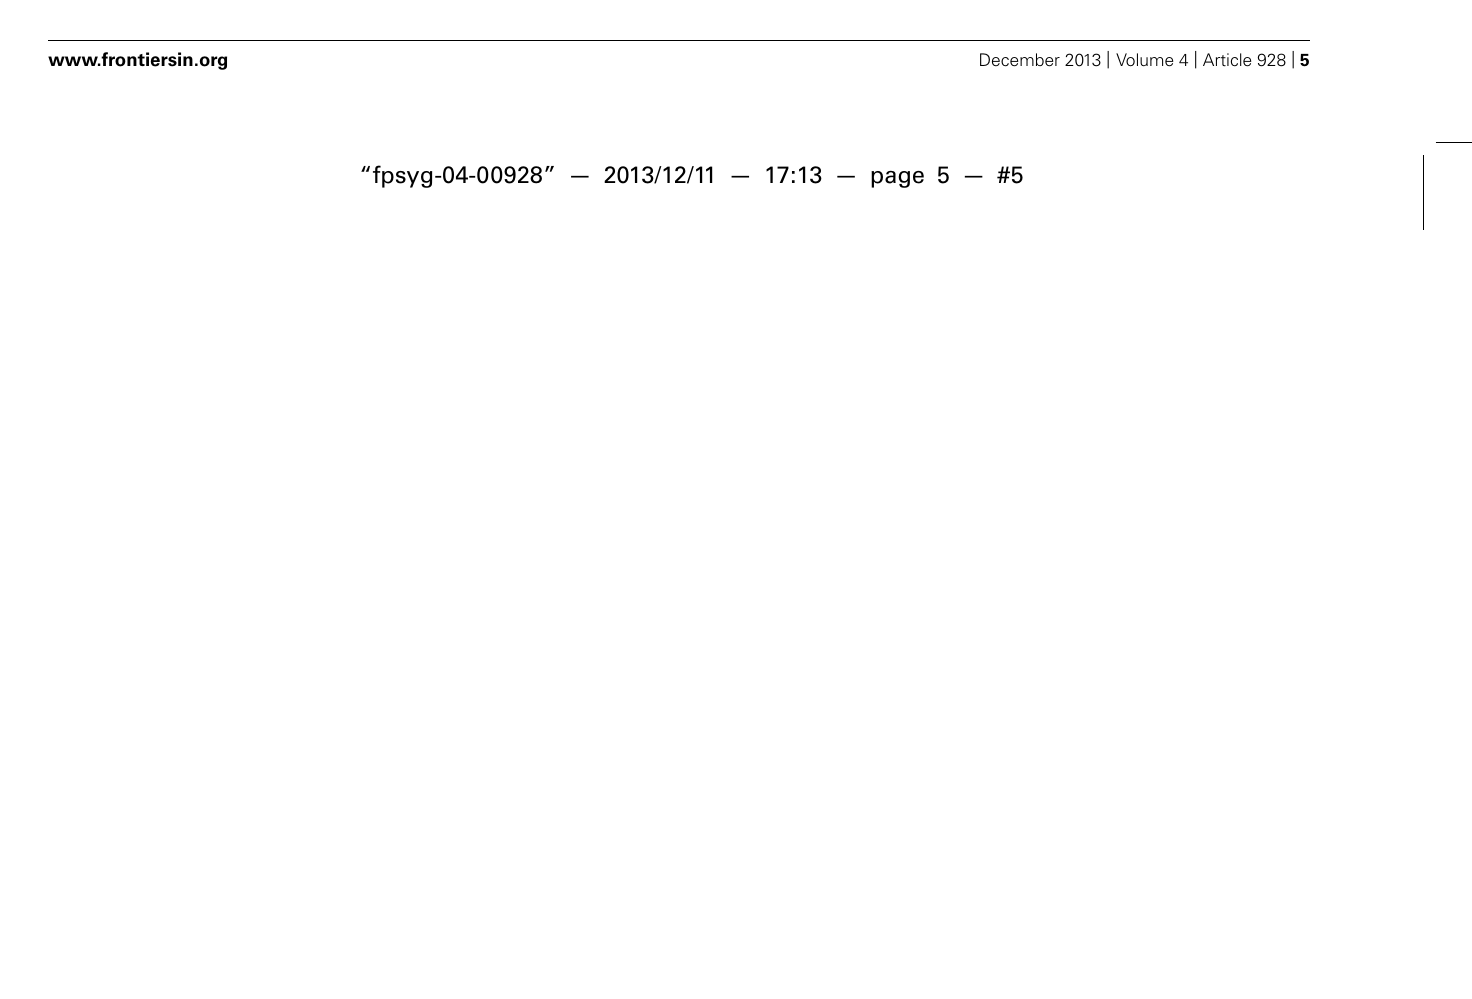
perceptual learning. (B) Activation is superimposed on a mean T1-weighted coronal section and displays the area in OFC exhibiting this correlation. OFC, orbitofrontal cortex (modified with permission from Li etal.,